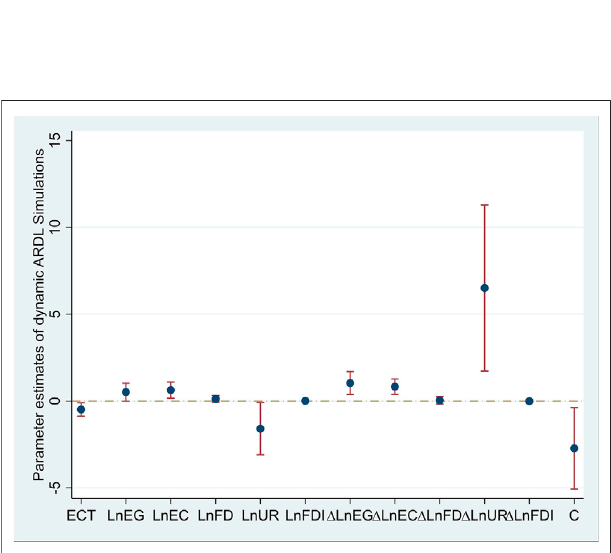
FIGURE 5 | Parameter estimates of DYNARDL simulations. Notes: the estimate in a log-log model is shown by the blue ( representedbythebrowntealdash-dot, and themarron-spike represents the lower and upper 95% con fi dence limit, respectively.